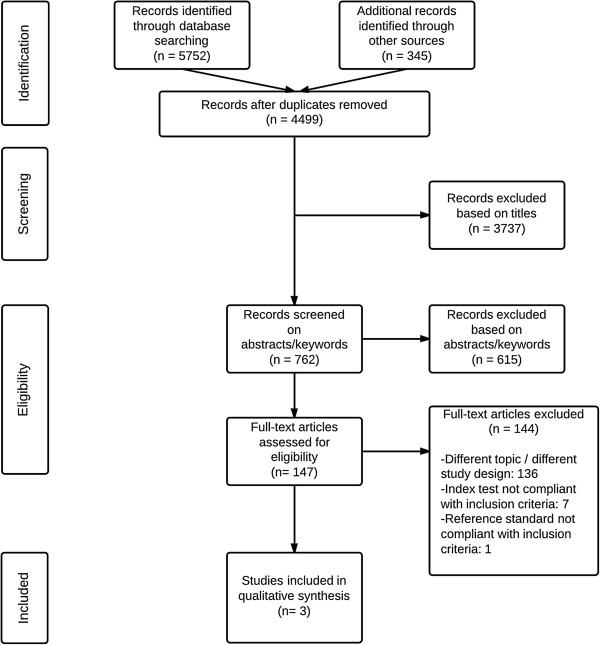
PRISMA flow diagram.